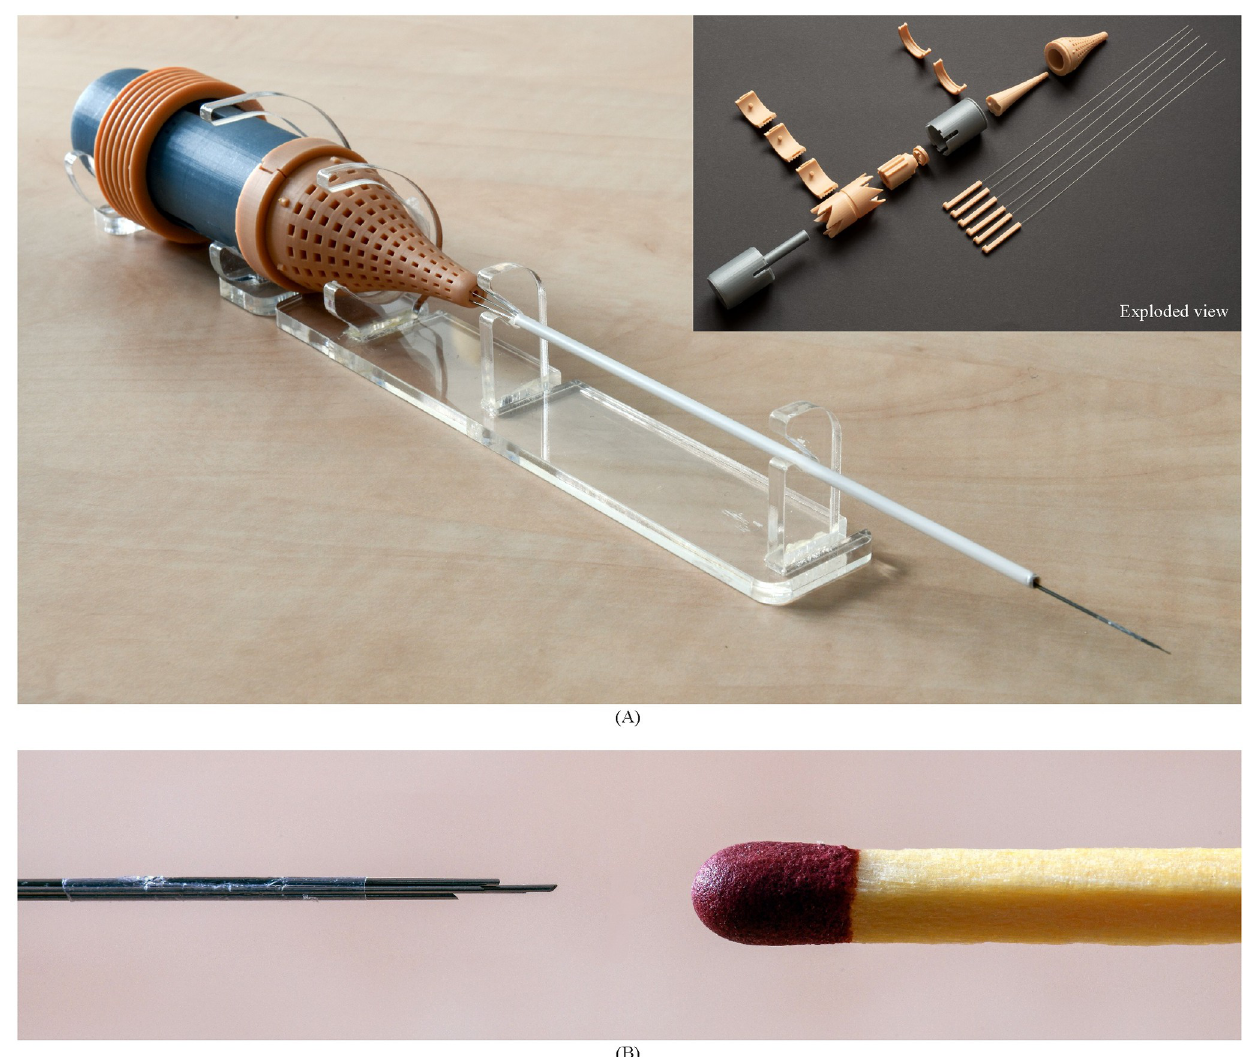
Fig 7. Ovipositor MRI-Needle (A) Close-up of the needle tip consisting of six sharpened Nitinol rods held together by a shrinking tube (Vention Medical) glued to one of the six rods. (B) Assembled prototype. The grey parts, i.e., the housing components, were produced using fused deposition technology (FDM) in polylactic acid (PLA) on an Ultimaker 3 printer. The orange parts, i.e., the actuation unit’s internal components and the inner and outer double cones, were produced using stereolithography (SLA) technology in Dental Model resin V2 (Formlabs) on a Formlabs Form 3B printer. A transparent polymethyl methacrylate (PMMA) support structure supports the prototype, and a white polylactic acid (PLA) guide tube supports the needle in the support structure.